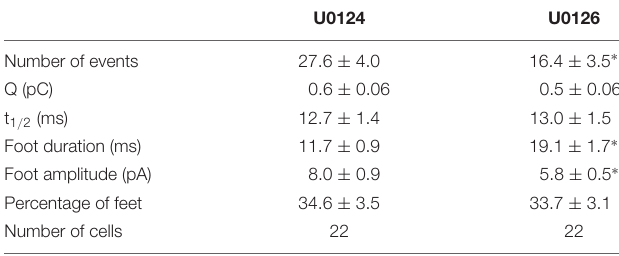
TABLE 1 | Effects of ERK1/2 signaling inhibition on